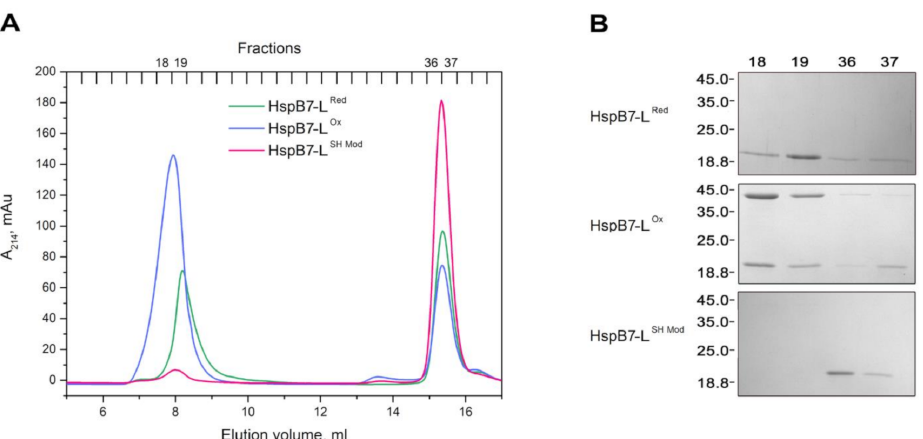
Figure 3. Oxidation and chemical modification of Cys residue affect oligomer structure of HspB7. ( A ) SEC of reduced (Red), oxidized (Ox), and modified by iodoacetamide (SH Mod) HspB7-L. ( B ) SDS- PAGE of high (fractions 18, 19) and low (fractions 36, 37) molecular weight oligomers under the nonreducing